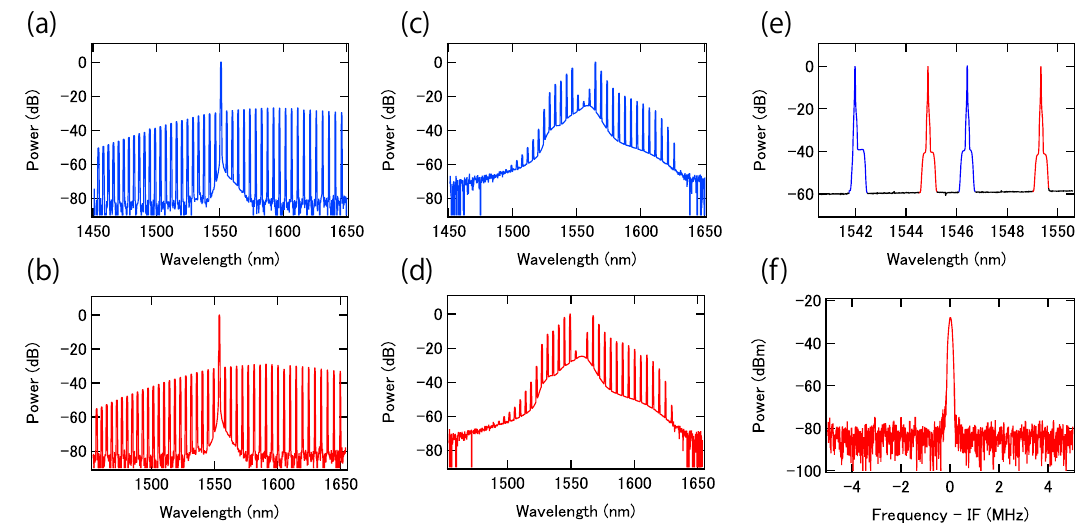
Fig. 3 Optical spectra and RF spectrum. Optical spectra of combs 1 ( a ) and 2 ( b ) before the bandstop fi lter and ampli fi ed optical spectra of combs 1 ( c ) and 2 ( d ) after the bandstop fi lter. e Optical spectrum of four comb modes (blue curve from comb 1 and red curve from comb 2) used for THz waves generation. f RF spectrum of the microwave generated from the SBD. Resolution bandwidth (RBW) for a – d is 1 nm. RBW for e is 0.02 nm. RBW for f is 100